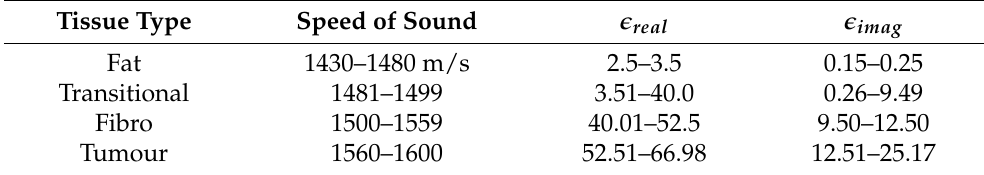
Table 2. Property ranges used in tissue-range mapping technique for Phantom